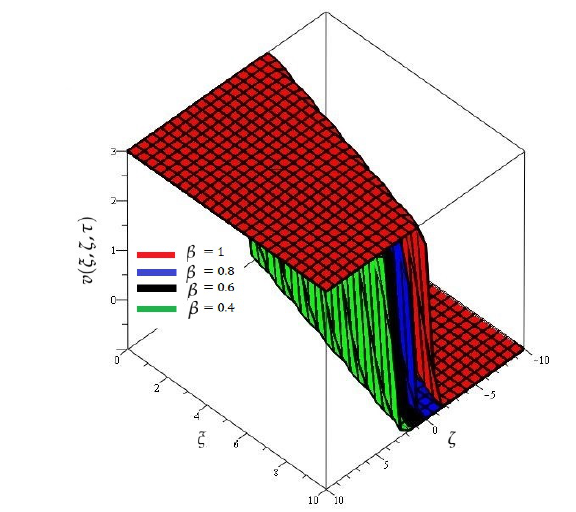
Figure 12. The numerical solution graph of v ( ξ , ζ , τ ) of Example 2 at different value of β